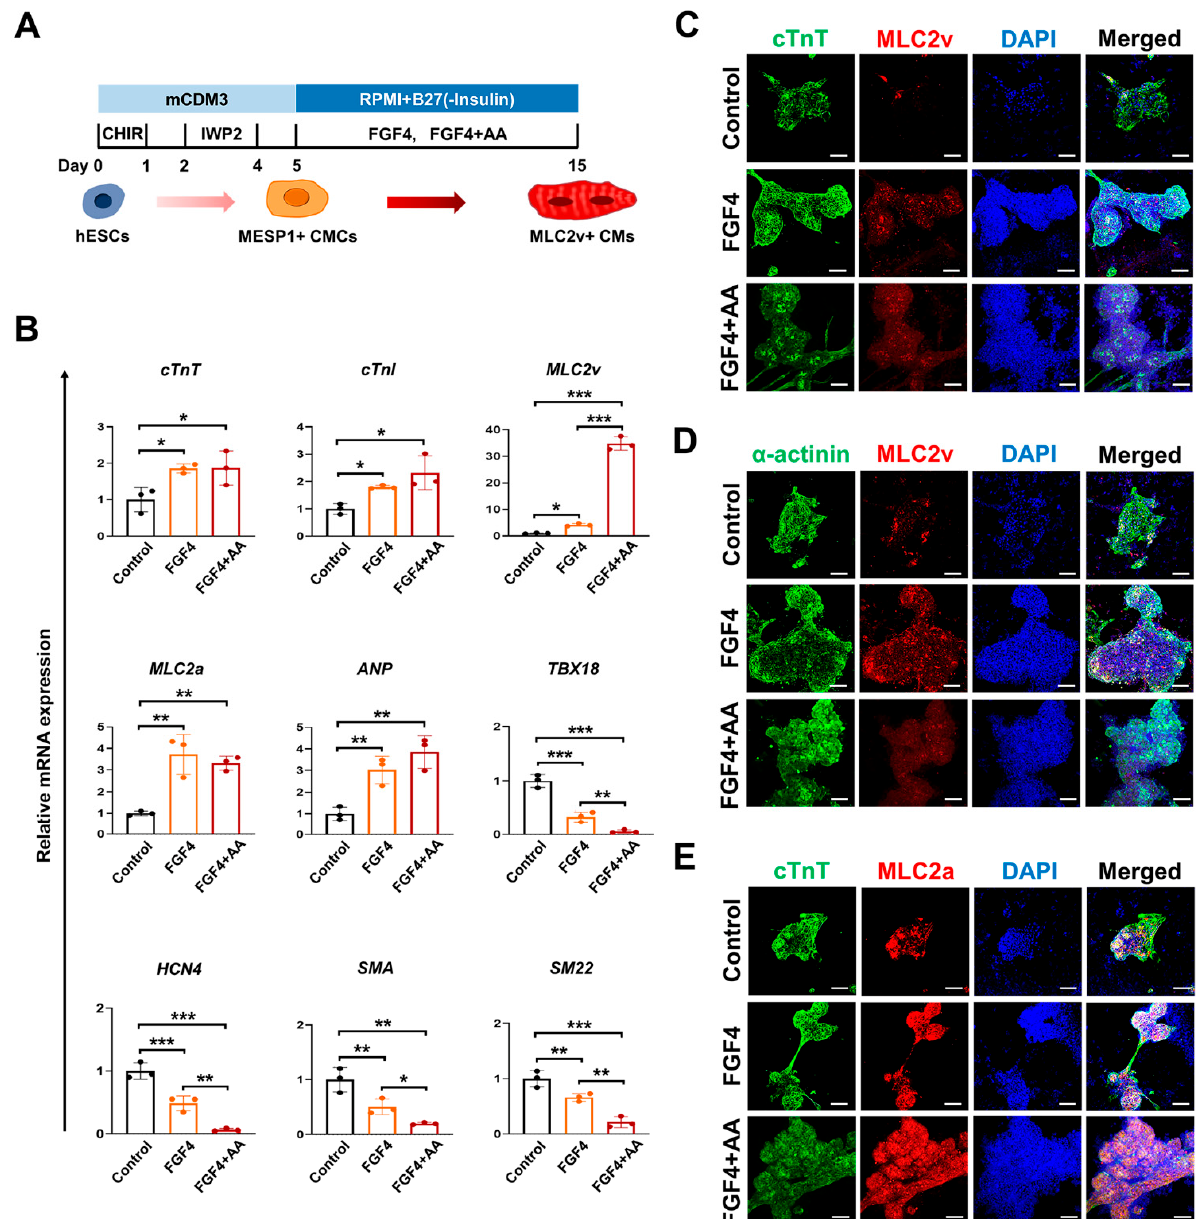
Figure 1. Co-treatment of FGF4+AA enhances differentiation of BG01 hESC-CMCs toward ventricular-like CMs but reduces differentiation into nodal-like CMs. ( A ) Schematic diagram of CM subtype differentiation protocol from BG01 hESC along with Wnt modulation followed by 10 ng/mL FGF4 or 10 ng/mL FGF4 + 200 µ g/mL AA between days 5 and 15 of differentiation in mCDM3 and RPMI/B27(-Insulin) media. CHIR: CHIR99021; CM: cardiomyocyte; CMC: cardiogenic mesoderm cell; mCDM3: modified chemically defined medium consisting of three components. ( B ) qRT-PCR analysis of a total CM marker (cTnT), a mature CM marker (cTnI), a ventricular CM marker (MLC2v), atrial CM markers (MLC2a, ANP), nodal CM markers (TBX18, HCN4), and smooth muscle cell markers (SMA, SM22) in BG01 hESC-CMCs treated with 10 ng/mL FGF4 or 10 ng/mL FGF4 + 200 μ g/mL AA in mCDM3 and RPMI/B27(-Insulin) media at differentiation day 15. Data were normalized to GAPDH level and expressed as relative values. Values represent means ± SDs. n = 3 for each group. * p < 0.05, ** p < 0.01 and *** p < 0.001 versus controls. Significant differences between the means of untreated-, FGF4-, and FGF4+AA-treated groups were analyzed by a one-way ANOVA followed by the Student–Newman–Keuls test. ( C – E ) Immunofluorescence images of BG01 hESC-CMs at differentiation day 15 after treatment with 10 ng/mL FGF4 or 10 ng/mL FGF4 + 200 μ g/mL AA. hESC-CMs were stained with the indicated antibodies. Nuclei were stained with DAPI (blue). Scale bars = 100 μ m.